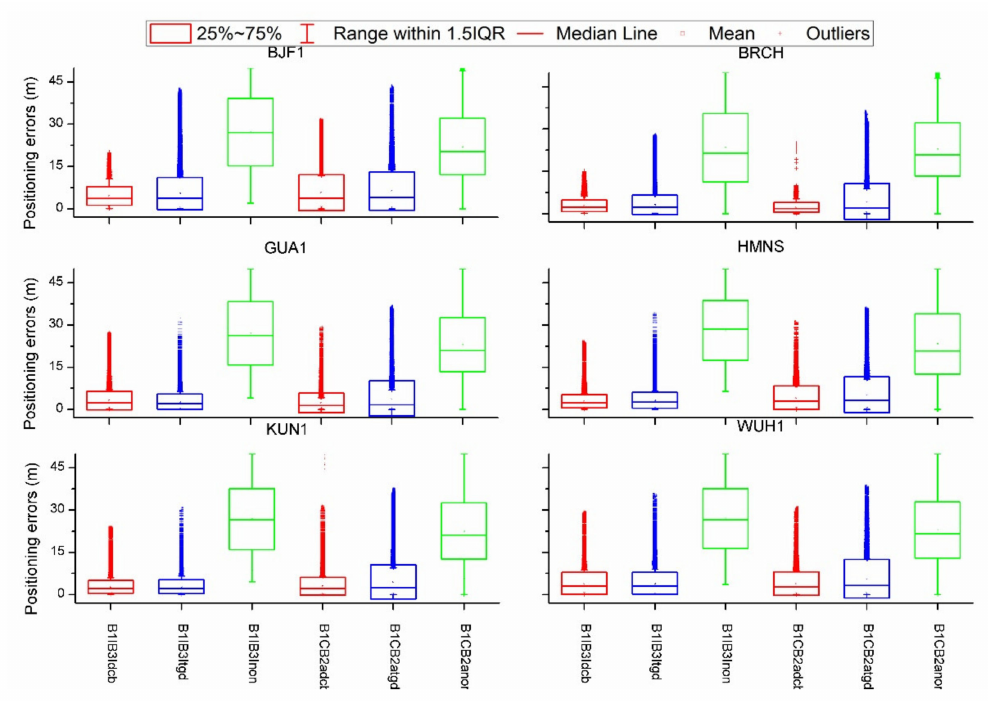
Figure 19. Boxplot of 3D positioning errors for dual-frequency SPP distributions in the non-corr (green), tgd-corr (blue) and dcb-corr (red) schemes for the period of April 2020.